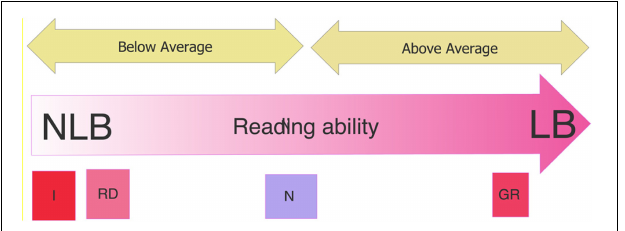
FIGURE 4 | Tasks and Dyslexia Spectrum superimposed [Illiterate (I), dyslexia (RD), normal or average reader (N), good reader